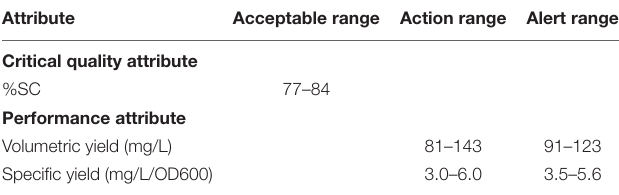
TABLE 7 | Ranges for CQA and